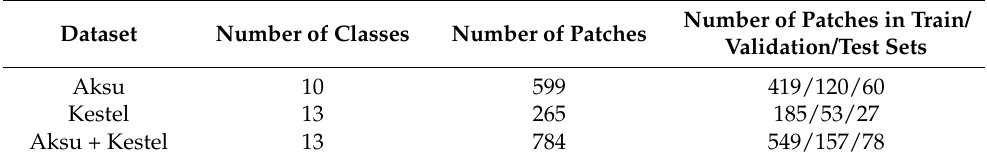
Table 1. Details of Worldview-3 image patches of the two study sites.